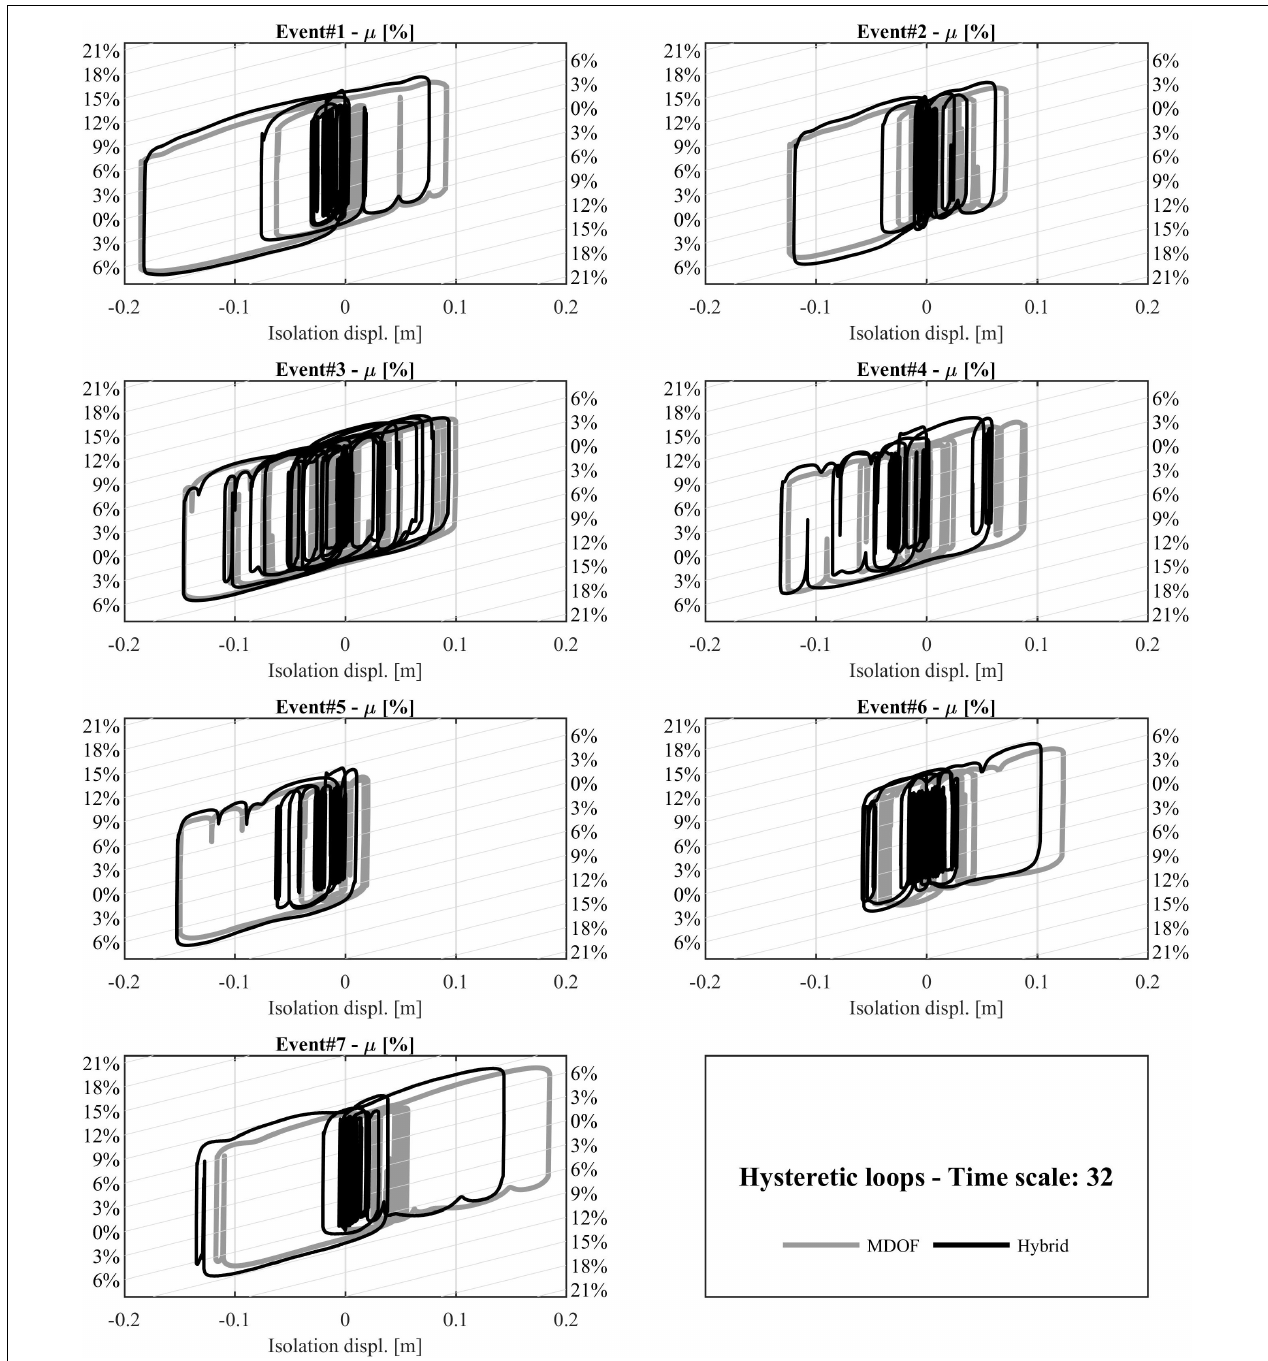
FIGURE 7 | Hysteretic response comparison—time scale